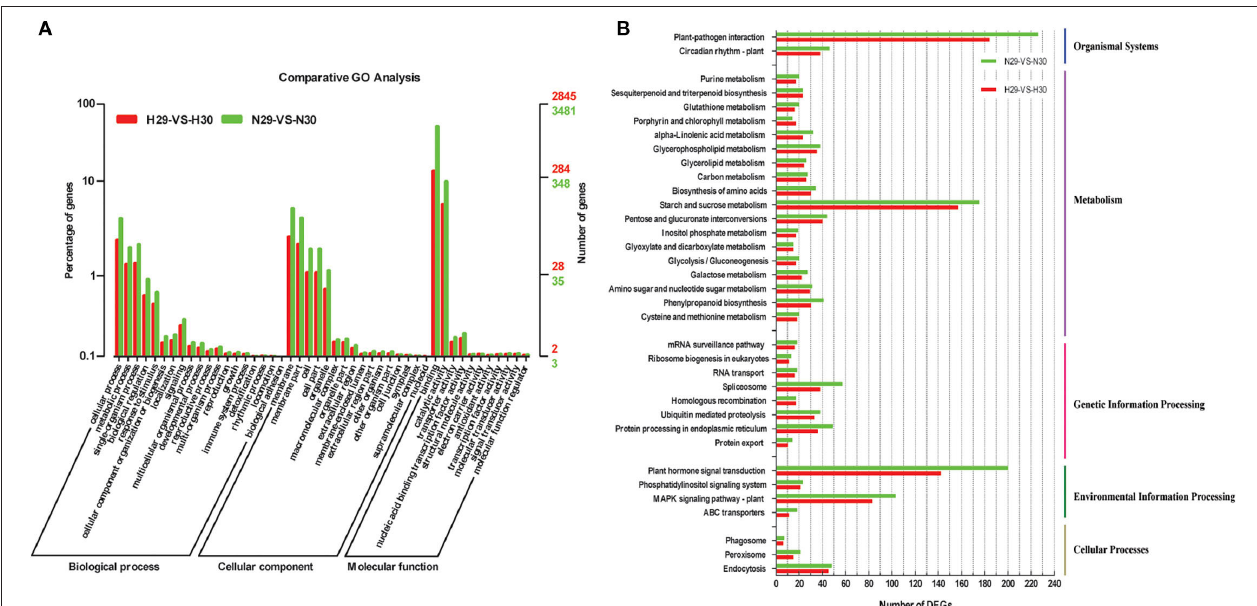
FIGURE 4 | Functional annotation of loquat transcripts based on gene ontology (GO) categorization (A) and KEGG classification (B) of DEGs. I, a total of 25,655 DEGs were classified into three main categories, including “biological process,” “cellular component,” and “molecular function.” The left y-axis represented the percentage of a specific category of DEGs in the main category. The right y-axis represented the number of DEGs in each category; II, a total of 2,820 DEGs were classified into five main categories, including organismal systems, metabolism, genetic information processing, environmental information processing, and cellular